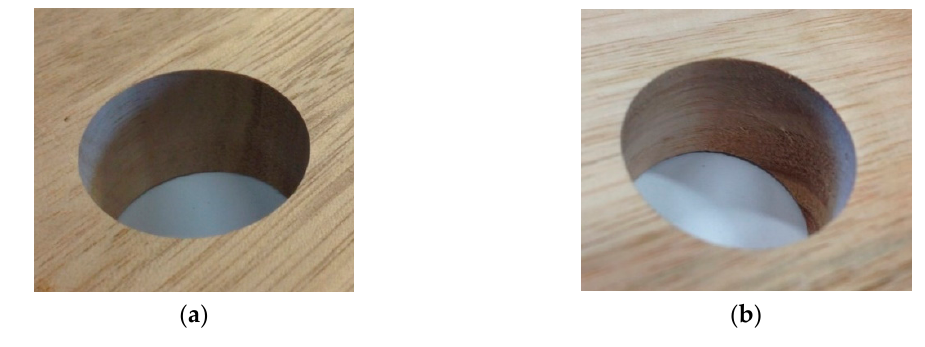
Figure 9. Examples of E. nitens with a grade of G0 (excellent) ( a ) and E. globulus with a grade of G2